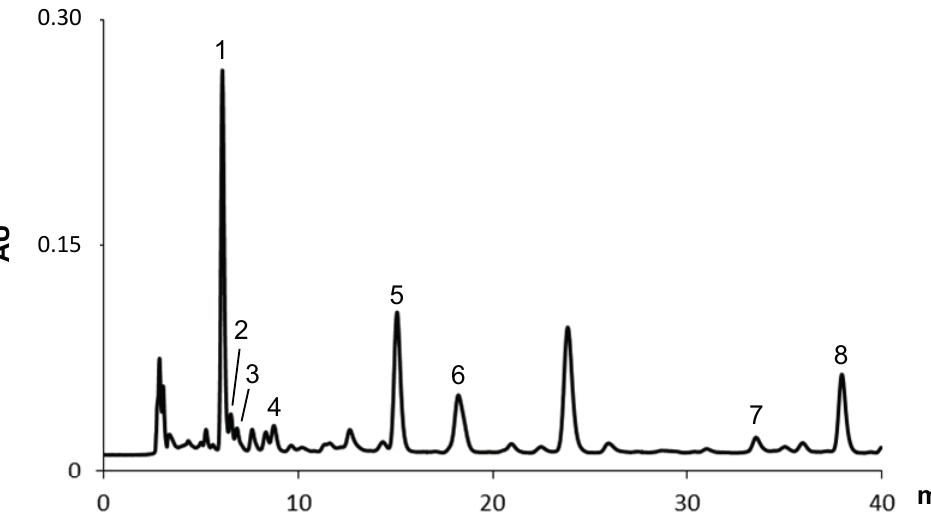
Figure 3. HPLC-DAD carotenoids profile of the methanol extract from the digestive gland of A. depilans . Detection at 450 nm. Peaks are identified in Table